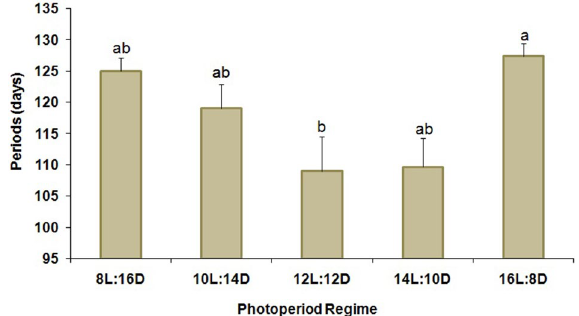
Figure 5. Developmental period (days ± SE) of P. interpunctella larvae that had been reared at 17 °C and different photoperiod regimes (means followed by the same letter are not significantly different; HSD test at